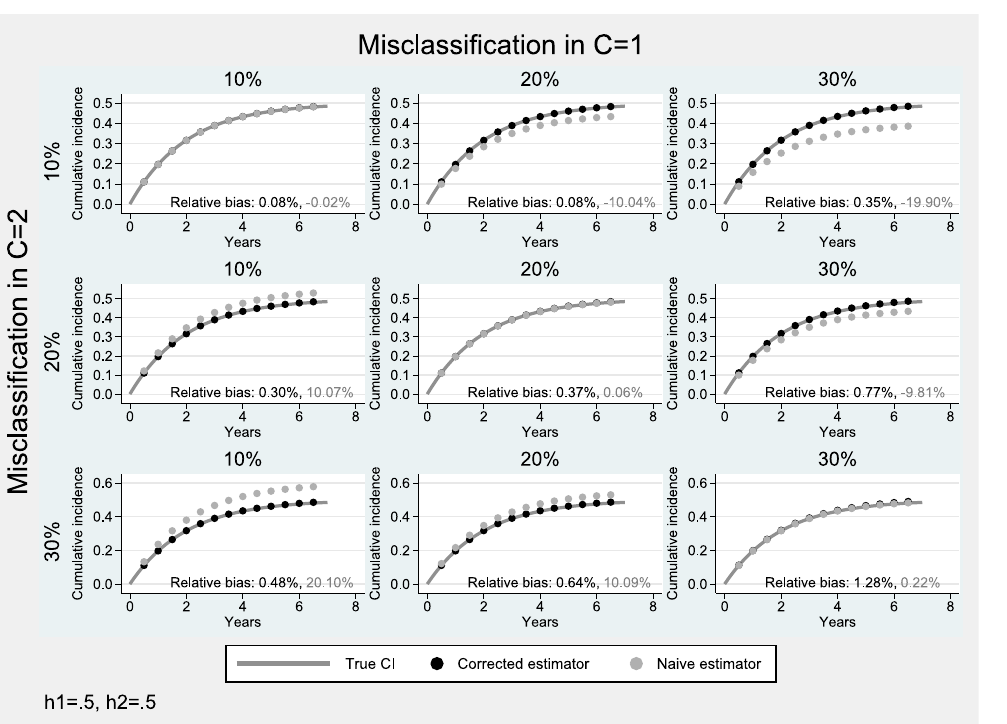
Fig 3. Simulation results for the case of bidirectional misclassification: Hazard parameter for the primary endpoint equal to that of the competing event ( h 1 = h 2 = 0.5). Solid lines correspond to the true cumulative incidence whereas dotted lines to the estimates from the non-parametric Aalen-Johansen estimator for the primary endpoint.